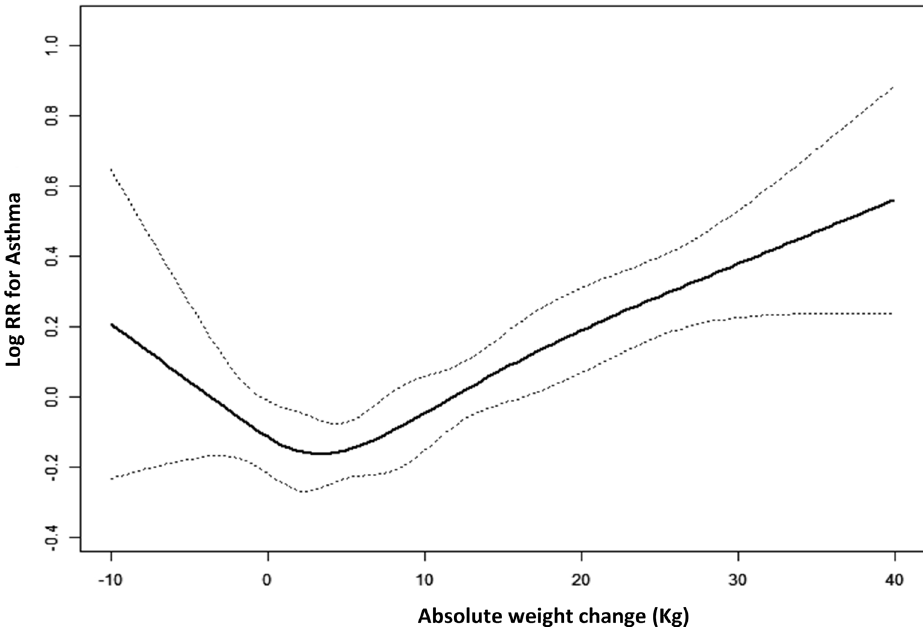
Figure 2. General additive models demonstrate the relationship between absolute weight change across adulthood and the risk of asthma. The resulting figures show the predicted log (relative risk) in the y-axis and the absolute weight change in the x-axis. The model was adjusted for gender, age at ten years before baseline, race/ethnicity, baseline family income, baseline education levels, and baseline smoking status.